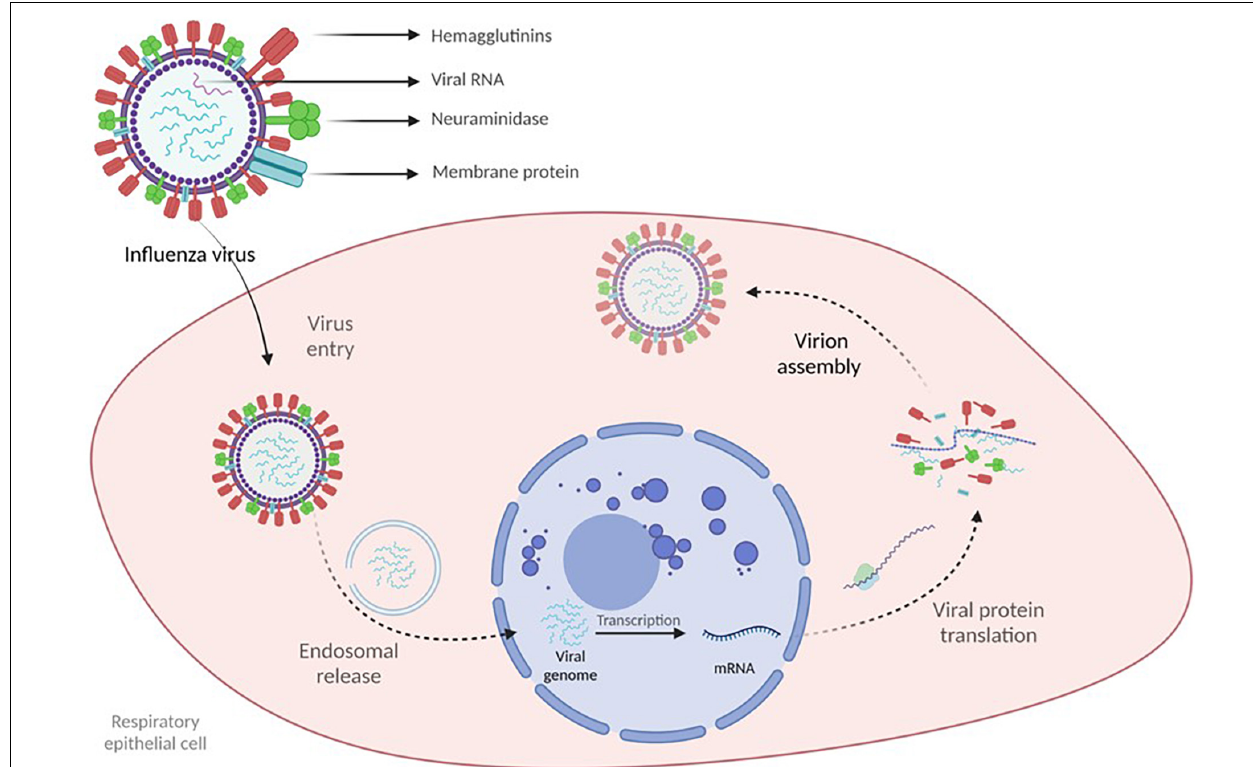
FIGURE 1 | Influenza virus structure and viral genome